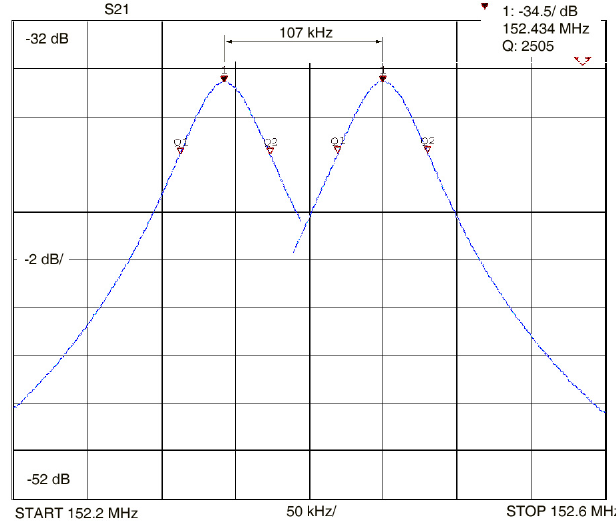
FIG. 8. (Color) Transmission characteristics S fitted with rotary tuner with l (cid:6) 23 : 6 mm at the rotor angle of 0 (cid:8) (left peak) and 90 (cid:8) (right